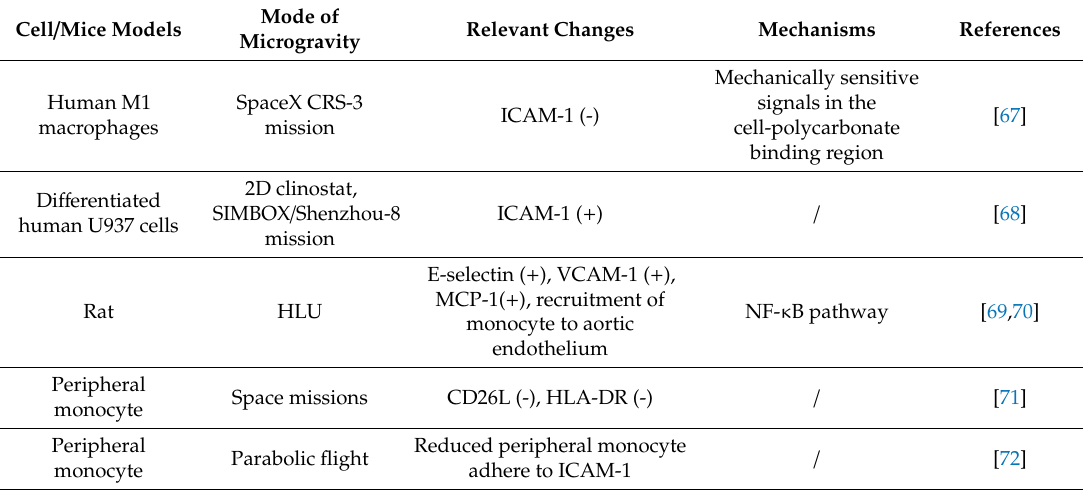
Table 3. E ff ects of microgravity on immune cells